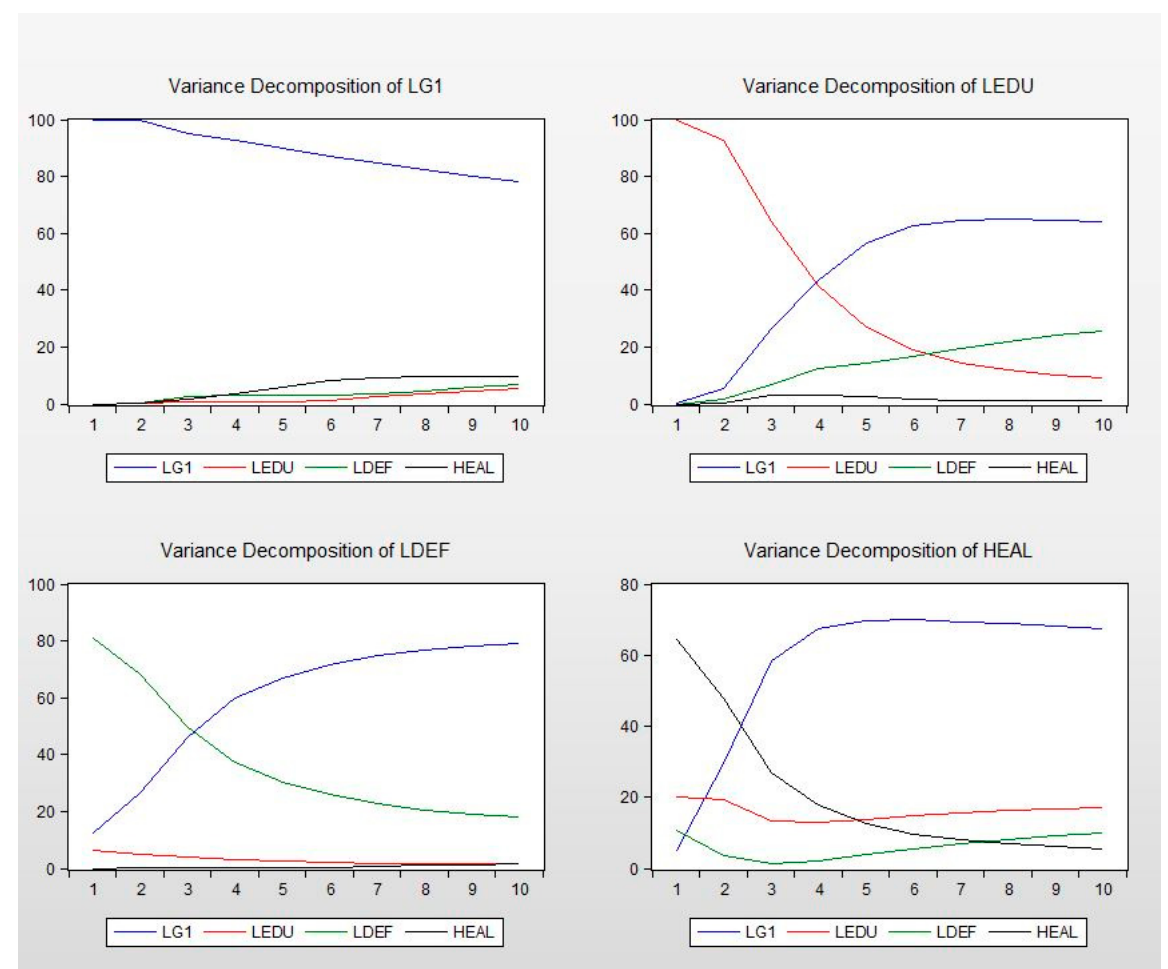
Figure 4. Variance Decomposition Analysis Graph.